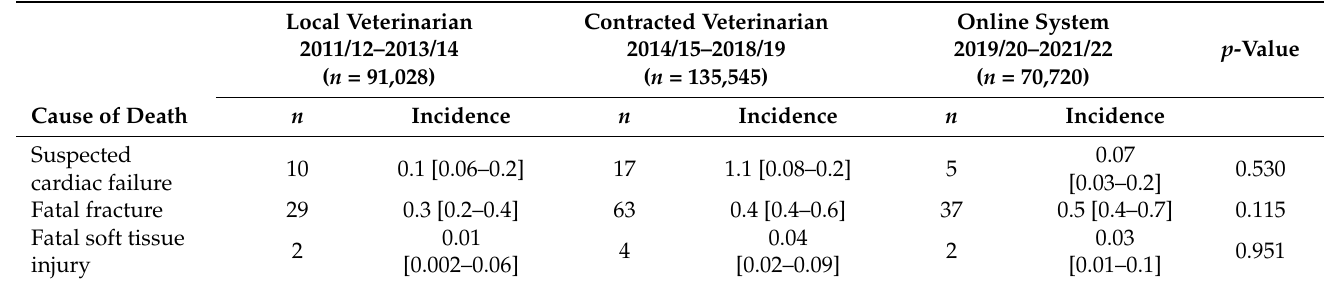
Table 1. Incidence rates and 95% confidence intervals for suspected cardiac failures, fatal fractures, and fatal soft tissue injuries by recording system for the 2011/12–2021/22 Thoroughbred flat racing seasons.